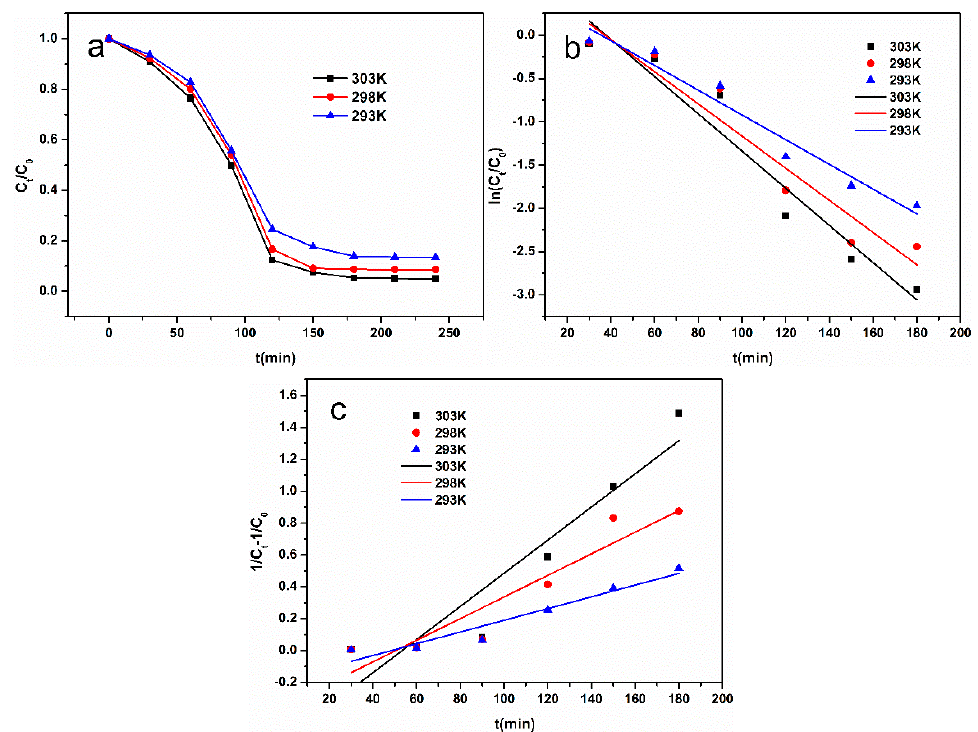
Figure 7. The catalytic degradation properties: ( a ) the kinetics of catalytic degradation; ( b ) the fitting diagram of first-order dynamics; ( c ) the fitting diagram of second-order dynamics.